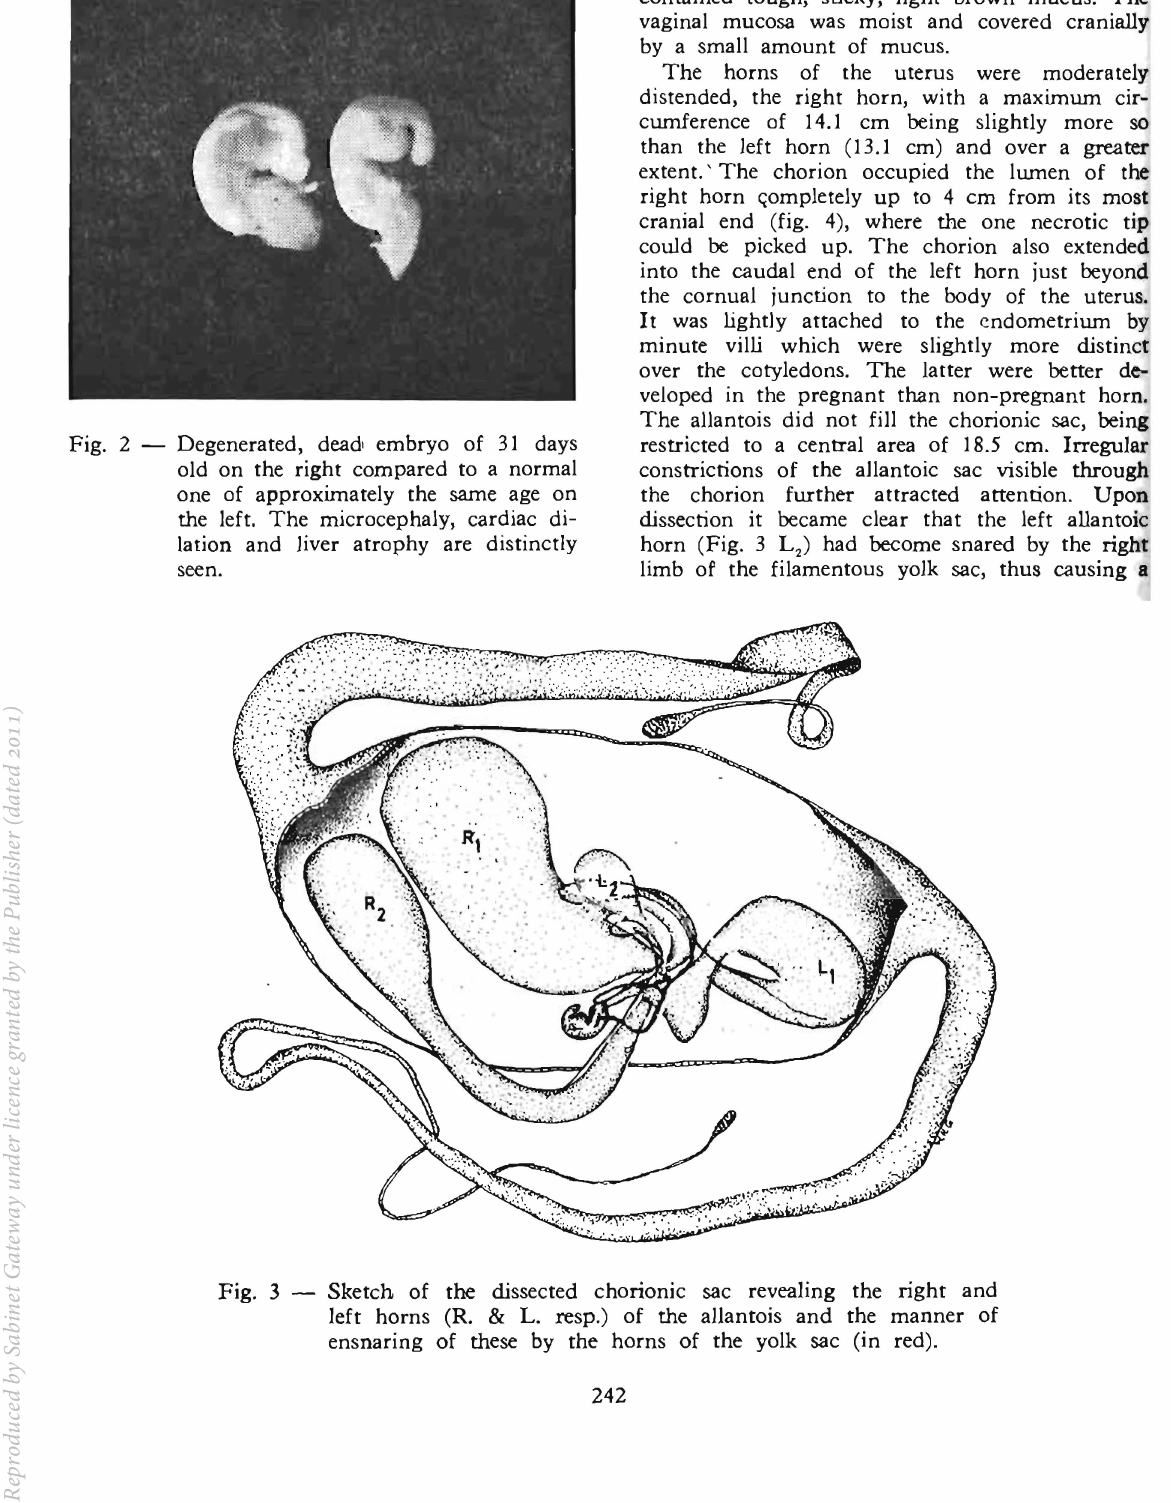
Fig. 3 - Sketch of the dissected chorionic sac revealing the right and left horns (R. & L. resp.) of the allantois and the manner of ensnaring of these by the horns of the yolk sac (in